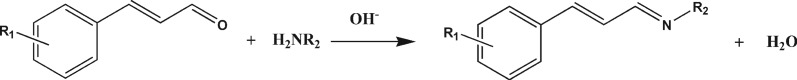
The synthesis route of cinnamaldehyde Schiff base.